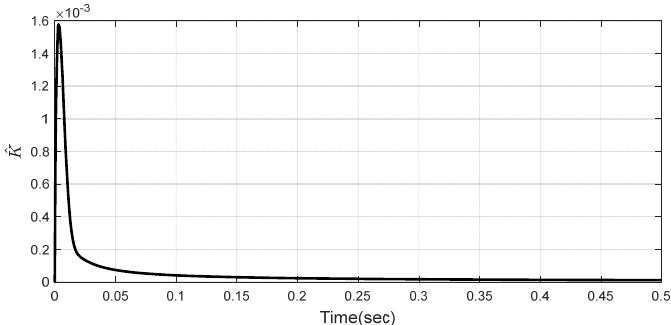
Figure 23. Adaptation gain.